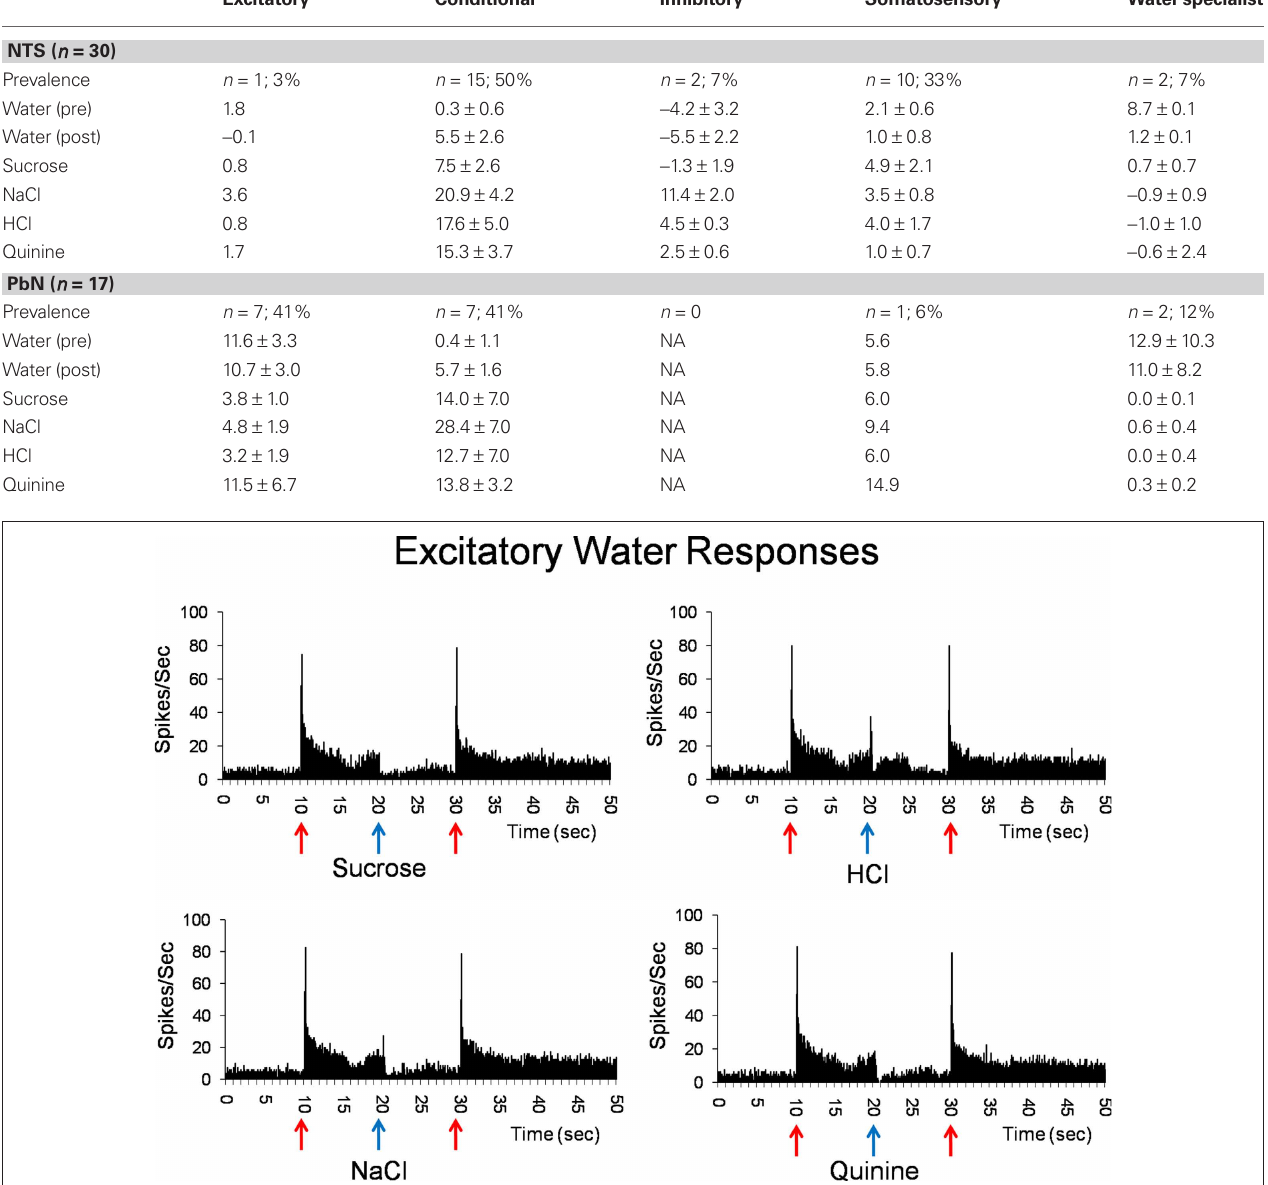
Figure 2 | Peristimulus time histograms showing the responses of a PbN water best cell to water (solid red arrows) and sucrose, NaCl, HCl, and quinine (blue arrows). Shown are eight stimulus presentations superimposed for each